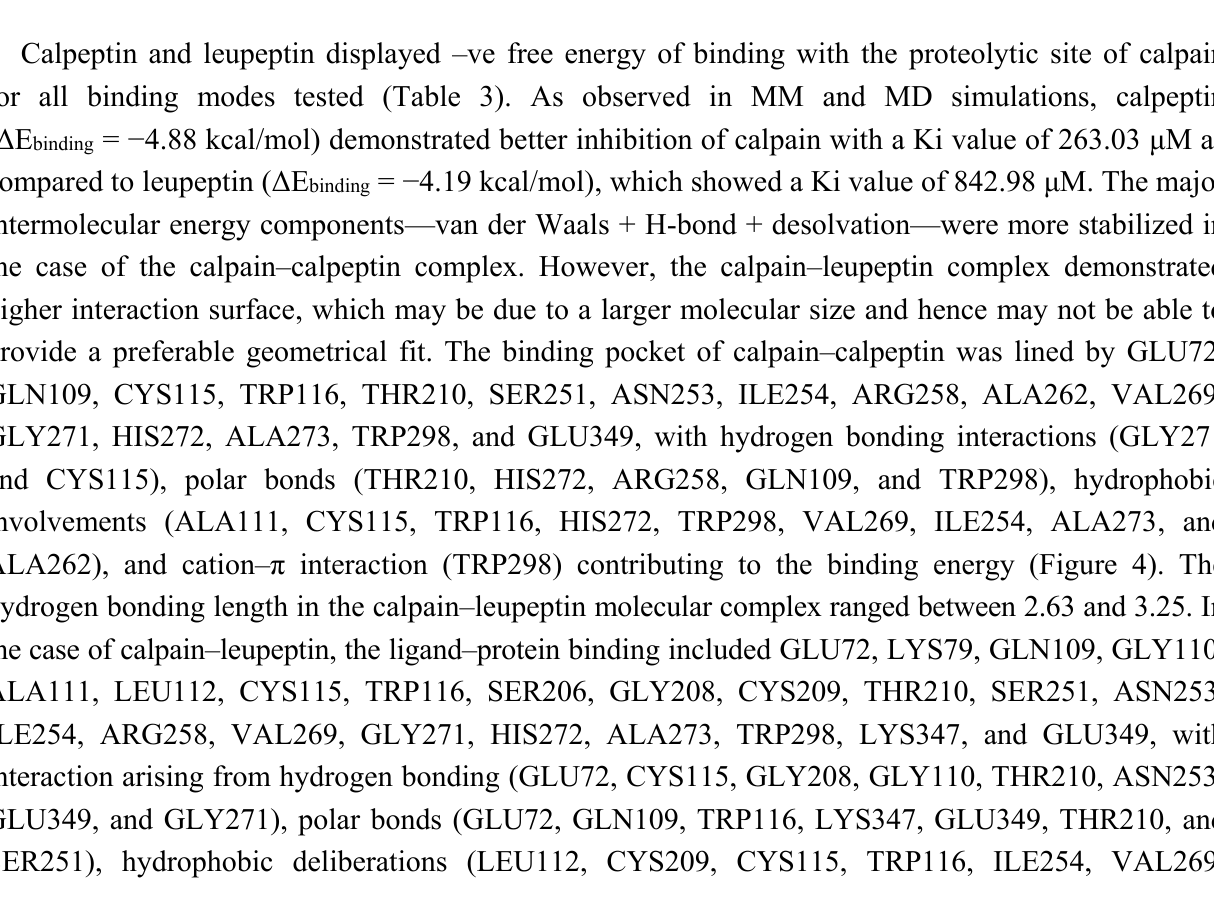
Figure 4. Visualization of the geometrical preferences of the calpain molecule (green secondary structure) in complexation with ligand molecules (yellow tube rendering). ( a ) Calpeptin and ( b ) leupeptin after molecular mechanics simulations. 3D-mapped isosurface plot representing the electrostatic potential for ( c ) calpain–calpeptin and ( d ) calpain–leupeptin. The kinetic energy (EKIN), potential energy (EPOT), and total energy (ETOT) values for ( e ) calpain–calpeptin and ( f ) calpain–leupeptin calculated by molecular dynamic simulations in vacuum. The most favorable poses of ( g ) calpeptin and ( h ) leupeptin within calpain were obtained via molecular